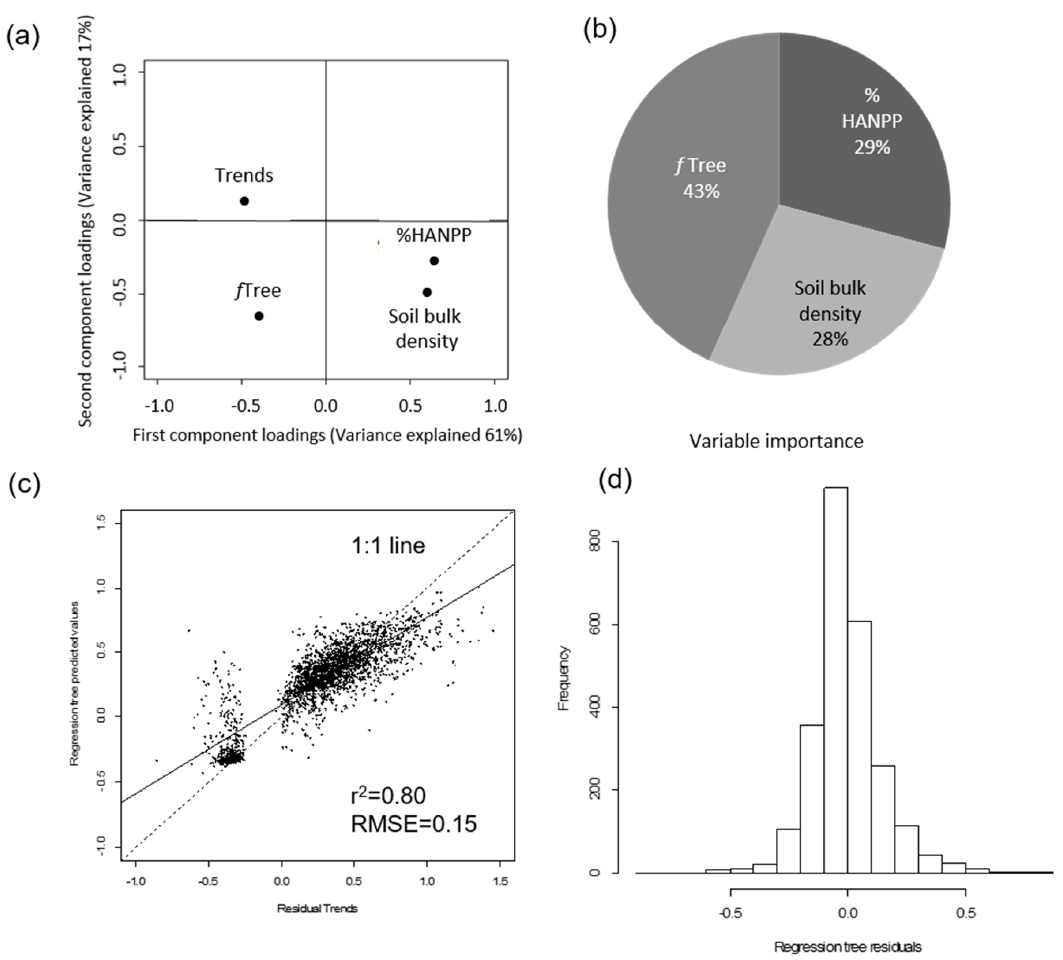
Figure 7. The relationship between significant RESTREND and the three explanatory variables, fraction tree cover (fTree), percentage human appropriation of NPP (%HANPP), and soil bulk density. ( a ) biplot of the first and second principal component loadings of a principal component analysis; ( b ) variable importance values calculated by the regression tree model Random Forest (RF); ( c ) comparison between RESTREND values modeled from the NDVI gs data time series (x-axis) and RESTREND values predicted by RF analysis (y-axis); and ( d ) histogram of the differences between the plotted values in ( c ). Residual trends insignificantly different from zero were excluded. Table 5. Spatial variation in RESTREND values correlated with %HANPP and soil properties, and %HANPP and land cover, using RF regression tree models.